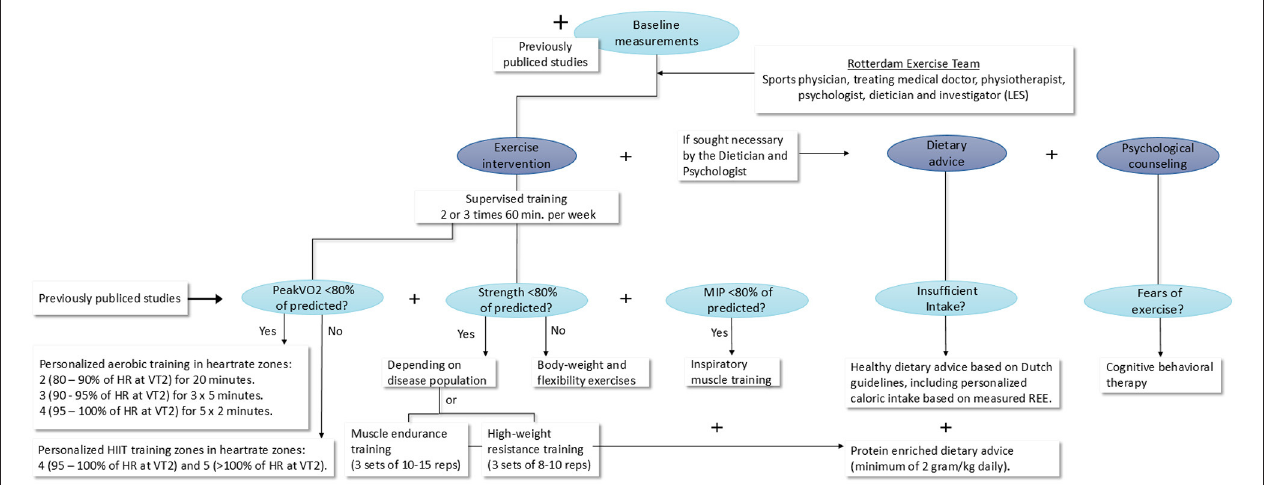
FIGURE 2 | Design process and content of the tailored exercise intervention. MIP, Maximal inspiratory pressure; min, minutes; HIIT, high intensity interval training; HR, heart rate; VT2, ventilatory anaerobic threshold; REE, rest energy expenditure; kg,